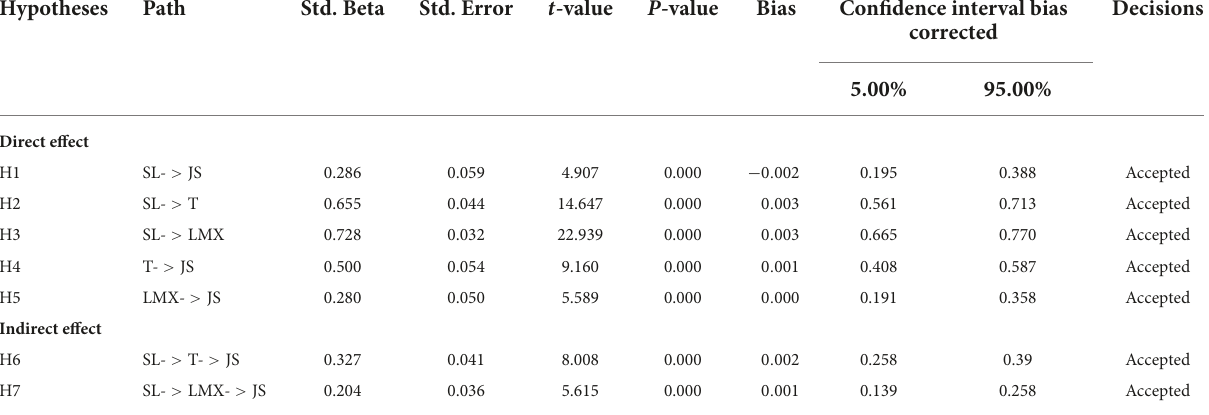
TABLE 7 Summary of hypotheses testing.